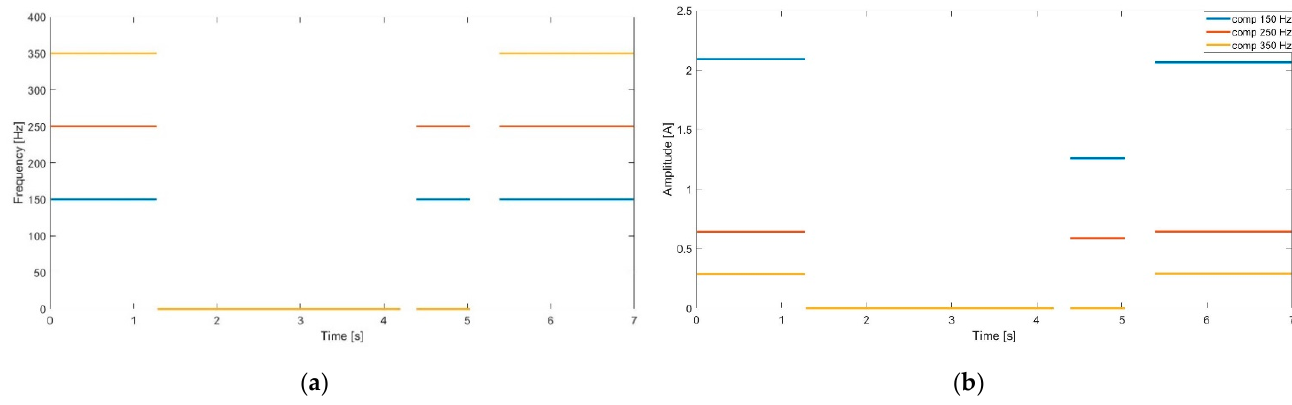
Figure 9. ( a ) Instantaneous frequencies and ( b ) amplitudes, of the mono-components extracted using the hybrid Hilbert- Huang method, of the microwave oven current described in Figure 6a.